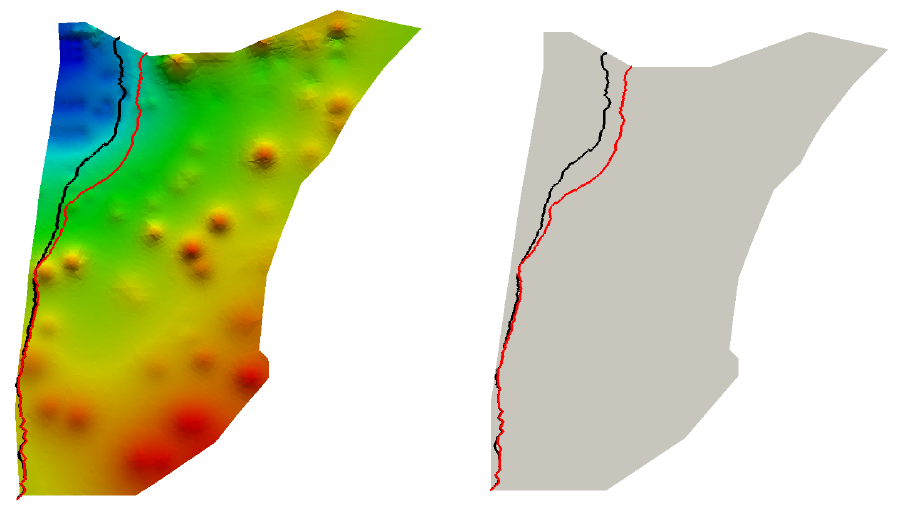
Figure 14. Position of the saltwater/freshwater interface in 1968 (black) and in 2048 (red).